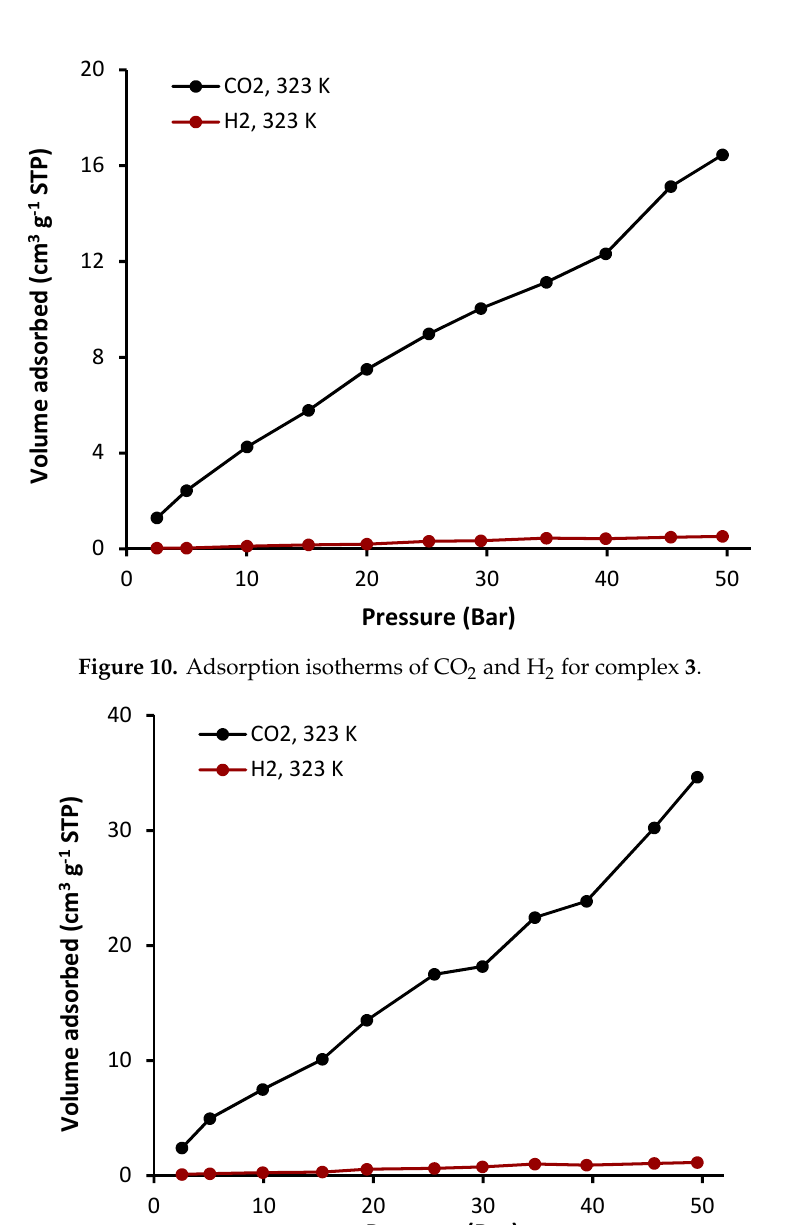
Figure 9. Adsorption isotherms of CO 2 and H 2 for complex 2 .